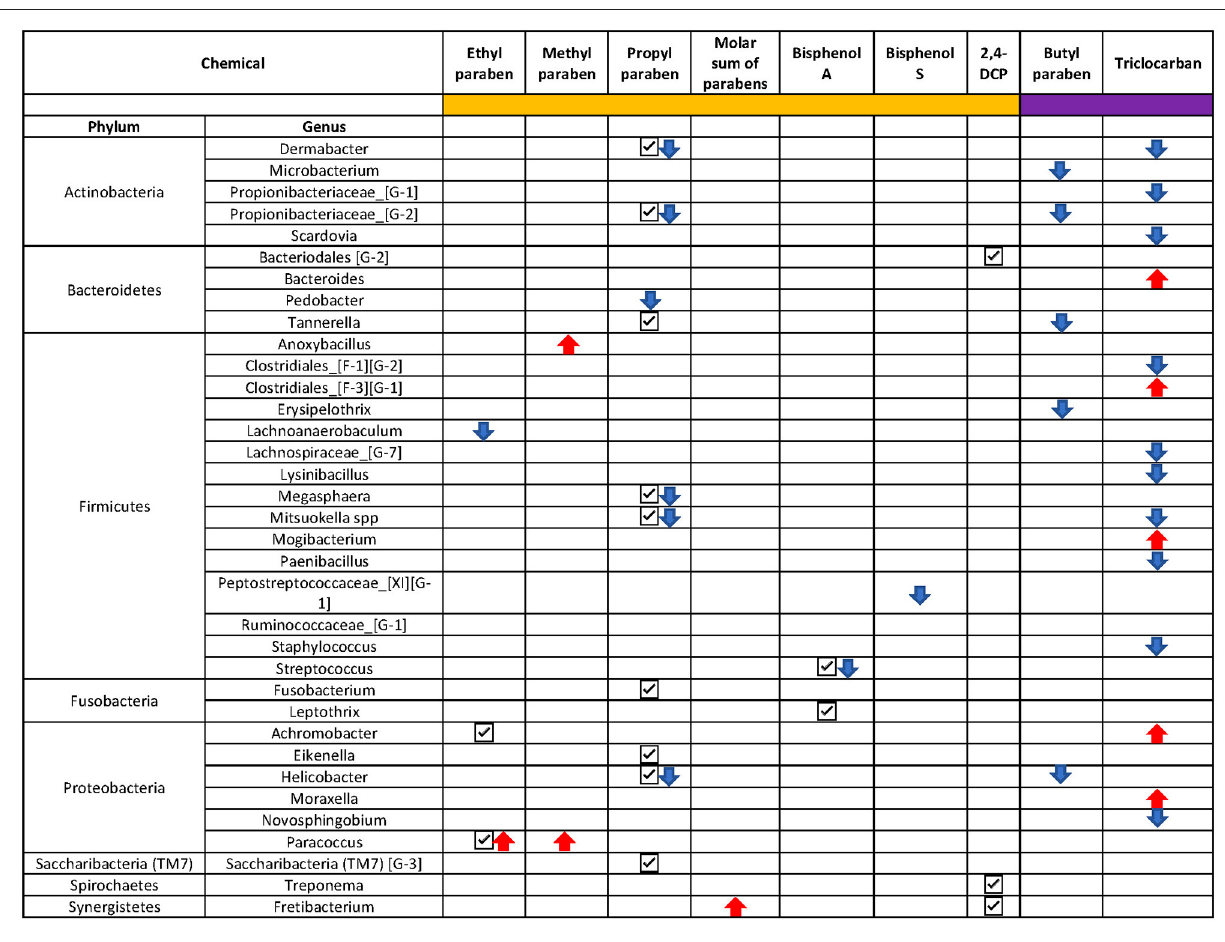
FIGURE 6 | Overview of the ANCOM-BC results. Only taxa with a p < 0.01 were presented. Chemicals with sidebar color in orange were categorized into quartiles and chemicals with sidebar color in purple were categorized into below and above the limit of detection. Check mark “ X ”: taxon was identified to be differentially abundant in at least one quartile of the chemical; downward arrow “ ”: taxon was identified to be monotonically decreasing as the increase of the chemical concentration; upward arrow “ ”: taxon was identified to be monotonically increasing as the chemical concentration